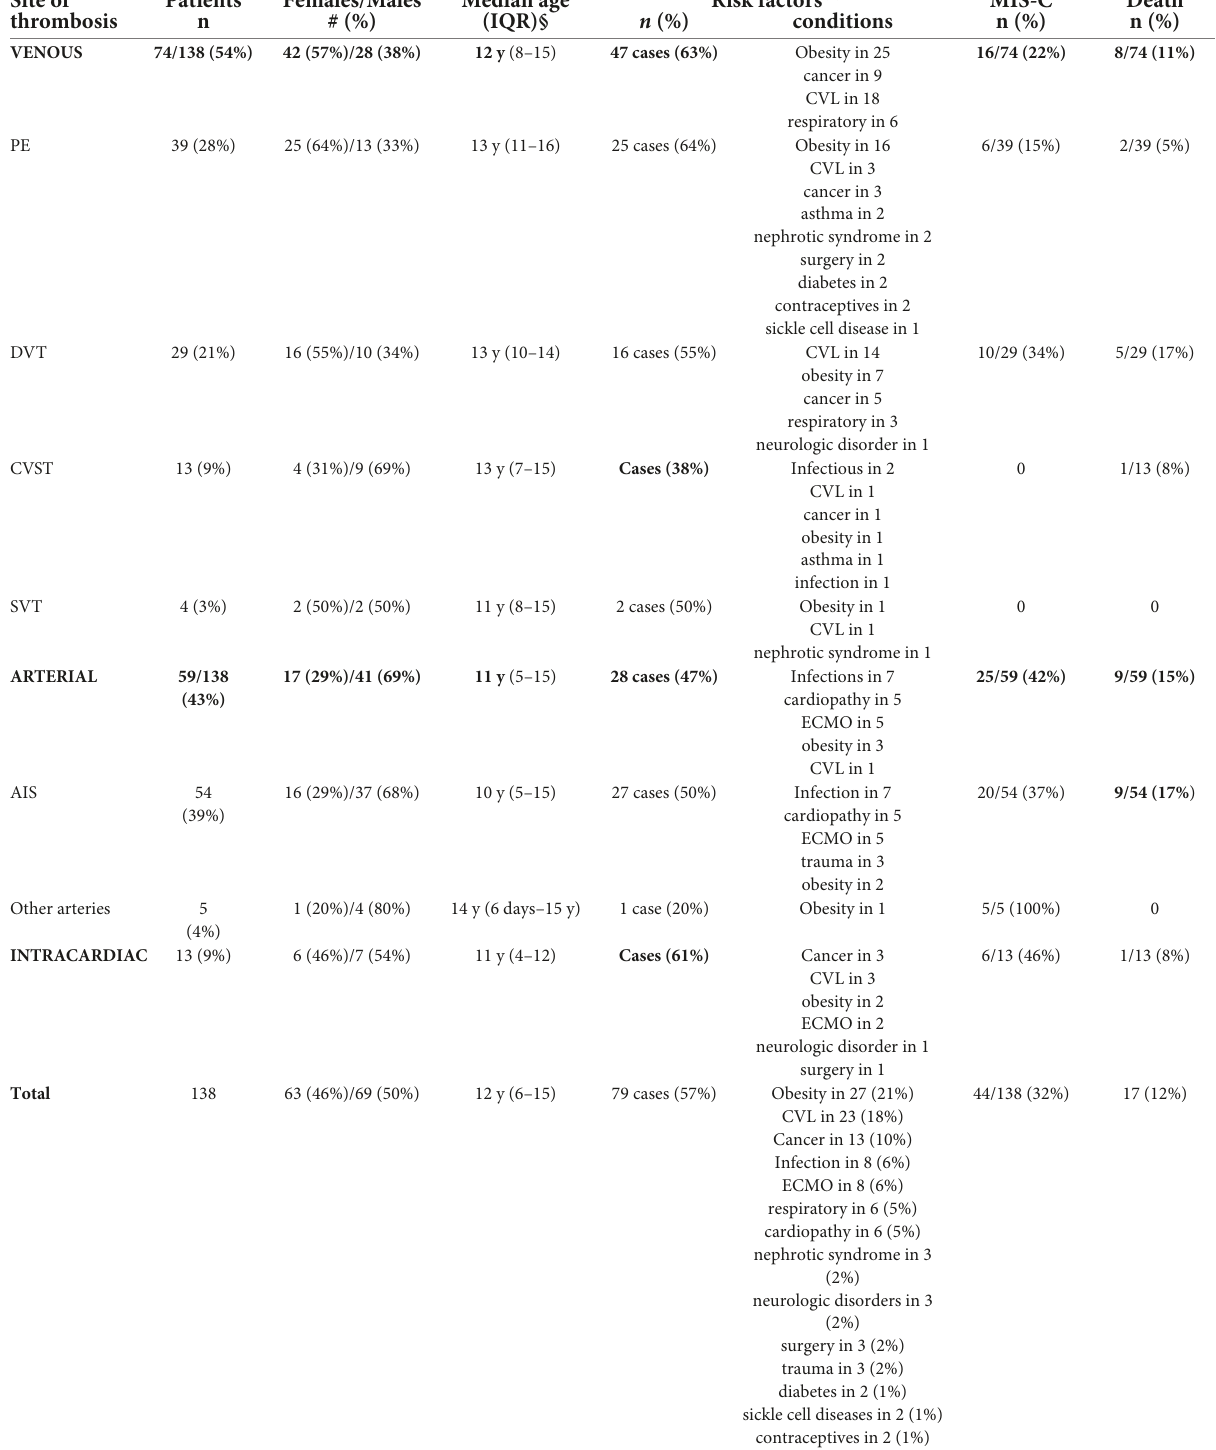
TABLE 1 Epidemiological data, risk factors, MIS-C association, and outcome of the 138 patients with TEs, categorized by site of thrombosis*. Site